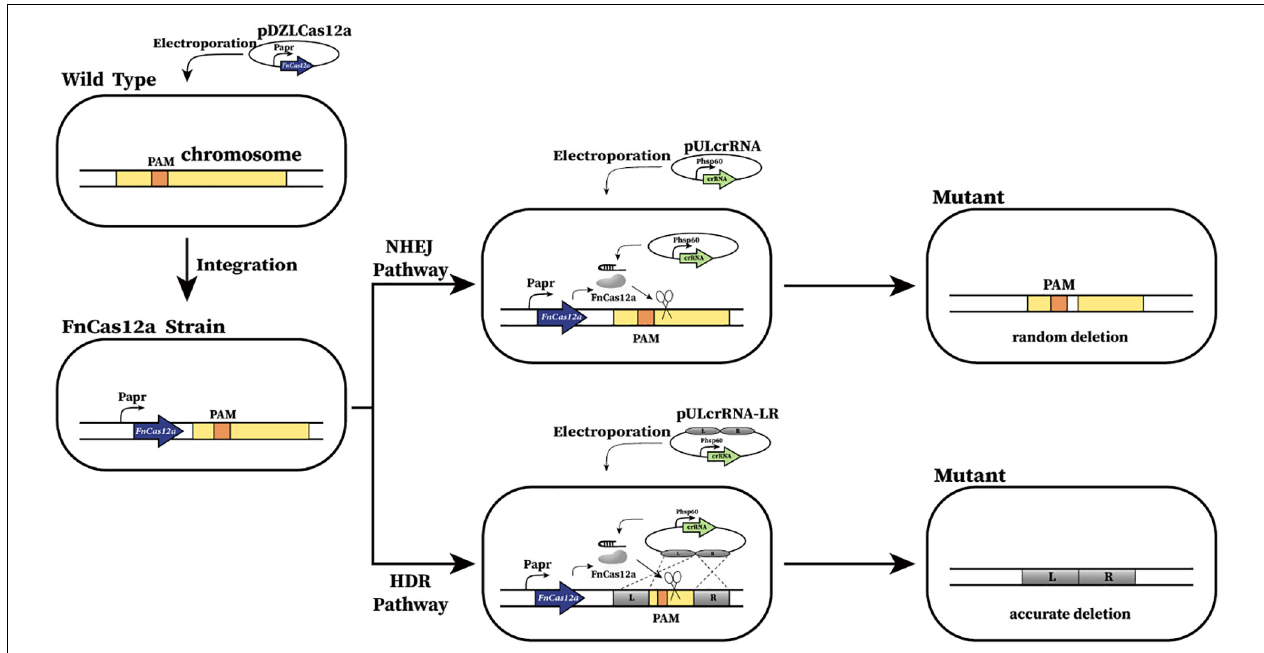
FIGURE 1 | Schematic of CRISPR-Cas12a-assisted genome editing in A. mediterranei U32. First, FnCas12a was integrated into U32 chromosome and constitutively expressed under the promoter of P apr . Then, the crRNA transcribing plasmid was electroporated into the U32 competent cells that harbored FnCas12a. Guided by a target-specific crRNA, Cas12a specifically cleaved target dsDNA and generated DSBs on the chromosome, which could be repaired by either NHEJ or HDR, generating desired mutants. When DSBs were repaired by NHEJ, the breaks were directly jointed with no homologous donor DNA required; however, DNA sequences of ranging length around the Cas12a cleavage site will be deleted during the